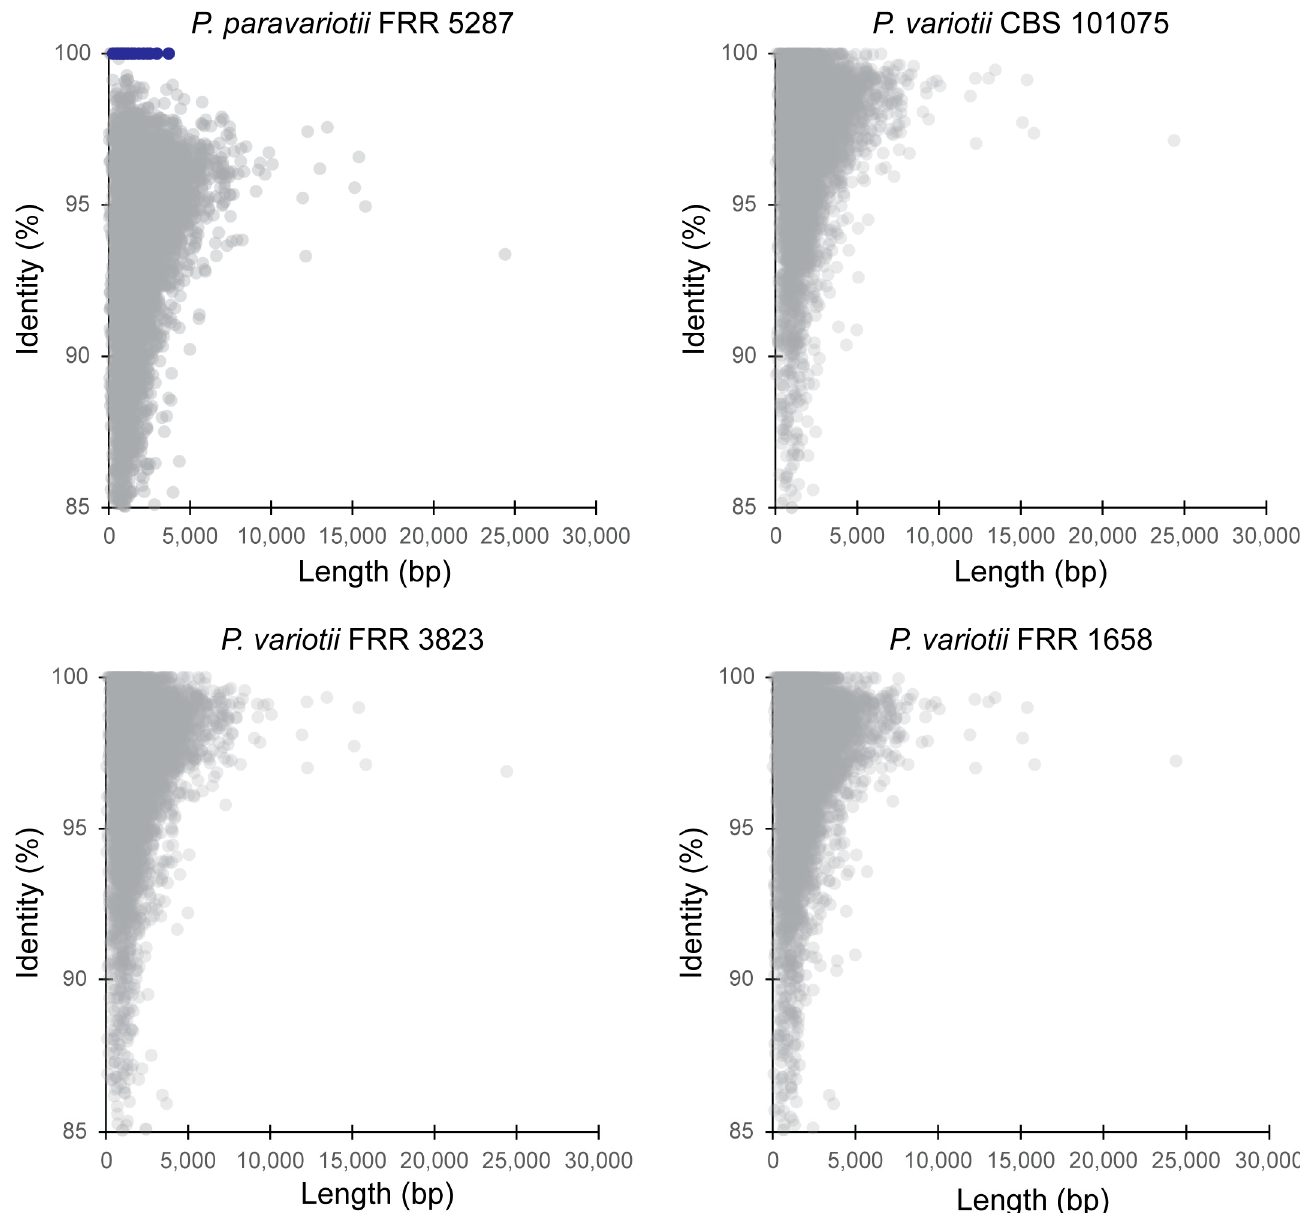
Figure 2. Genome-wide assessment of divergence between P. variotii and P. paravariotii using a BLAST all-vs.-all approach. Each comparison is to the P. variotii CBS 144490 gene regions. Blue colour indicates genes contained within the HEPHAESTUS transposable